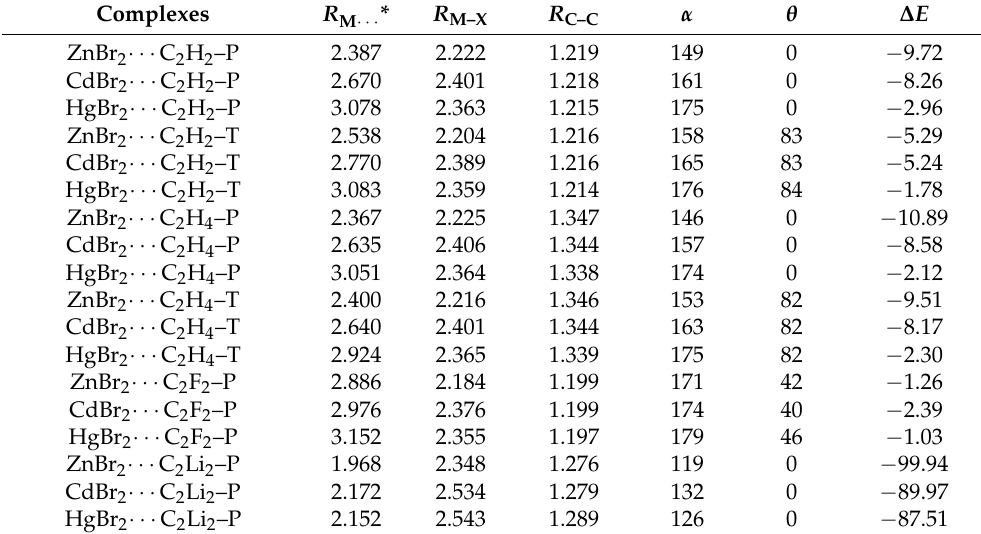
Table 2. Binding distance ( R M ··· * in Å) between the M in MX 2 and the centers of C–C bond in π molecules (* denotes the center of C–C bond), M − X ( R Å) of complexes, X-M-X angle ( α in degrees), and dihedral angle of X–X · · · C–C ( θ in degrees), and interaction energies ( ∆ E , kcal/mol) in the